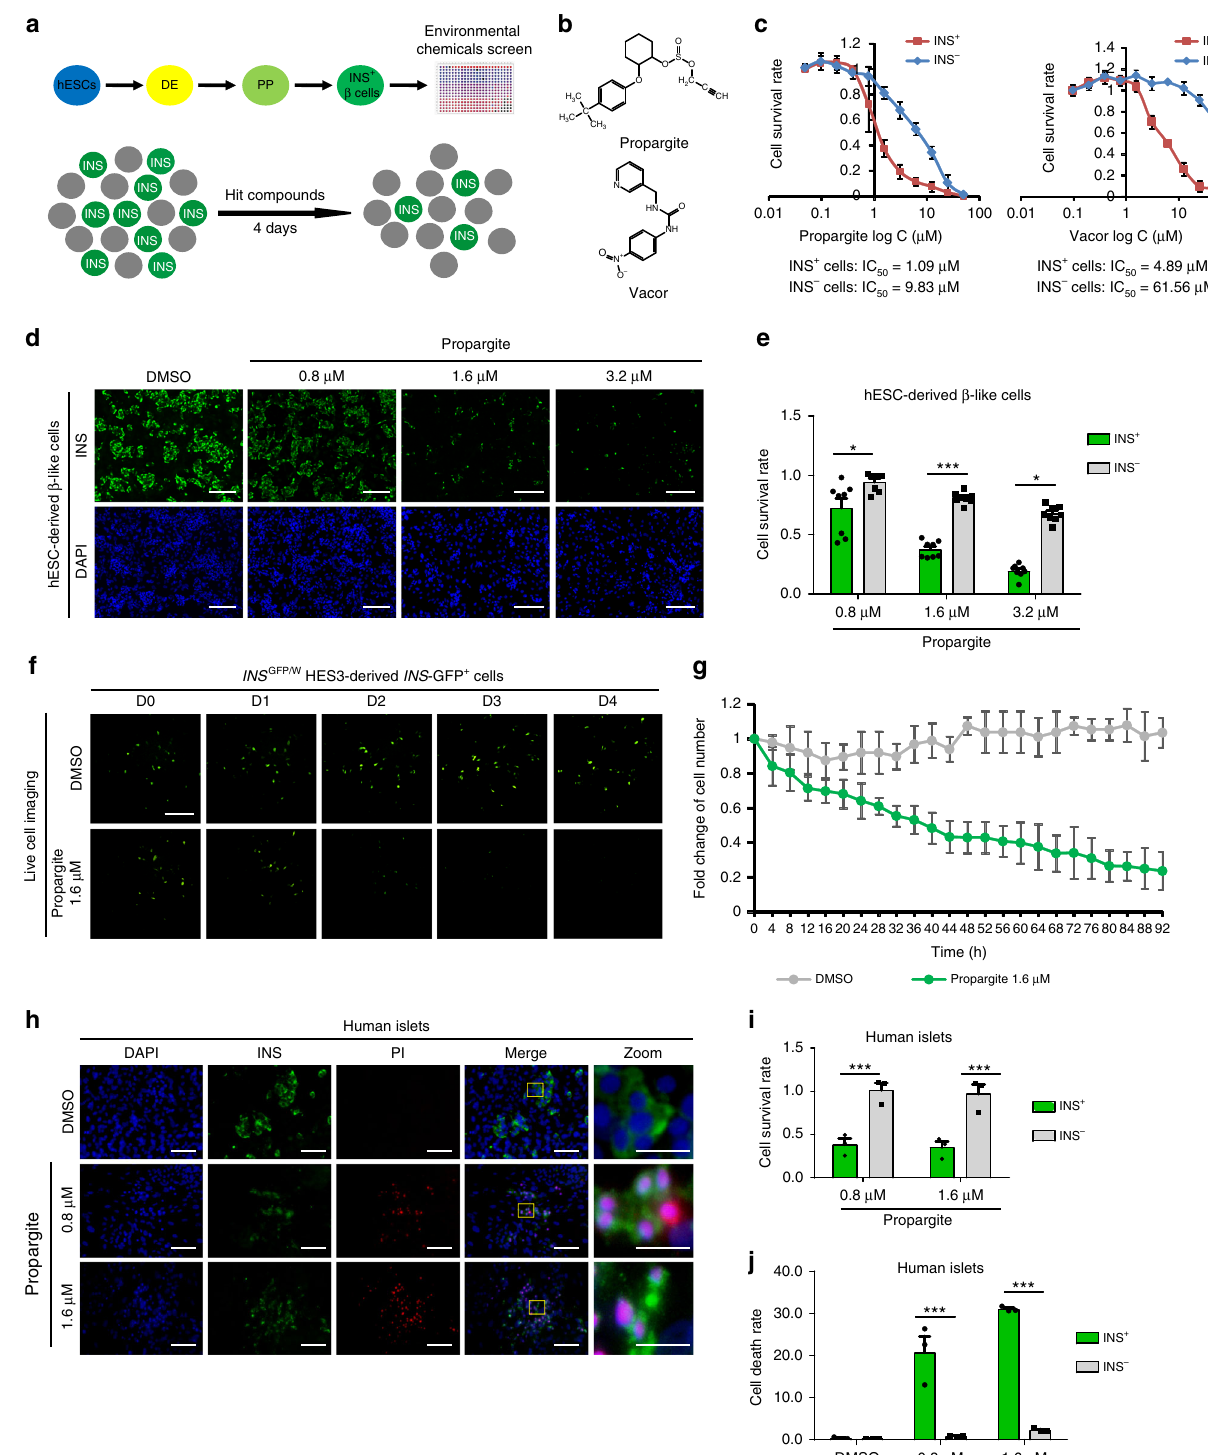
analysis showed “ regulation of DNA-dependent transcription ” among the top downregulated pathways upon Propargite treat- ment (Fig. 2a). In contrast, genes associated with chromatin assembly and cell death-related processes were upregulated under those conditions (Fig. 2a). Several genes that were highly upre- gulated (fold-change >3) in the propargite-treated cells were related to DNA damage, including, DNA damage-inducible